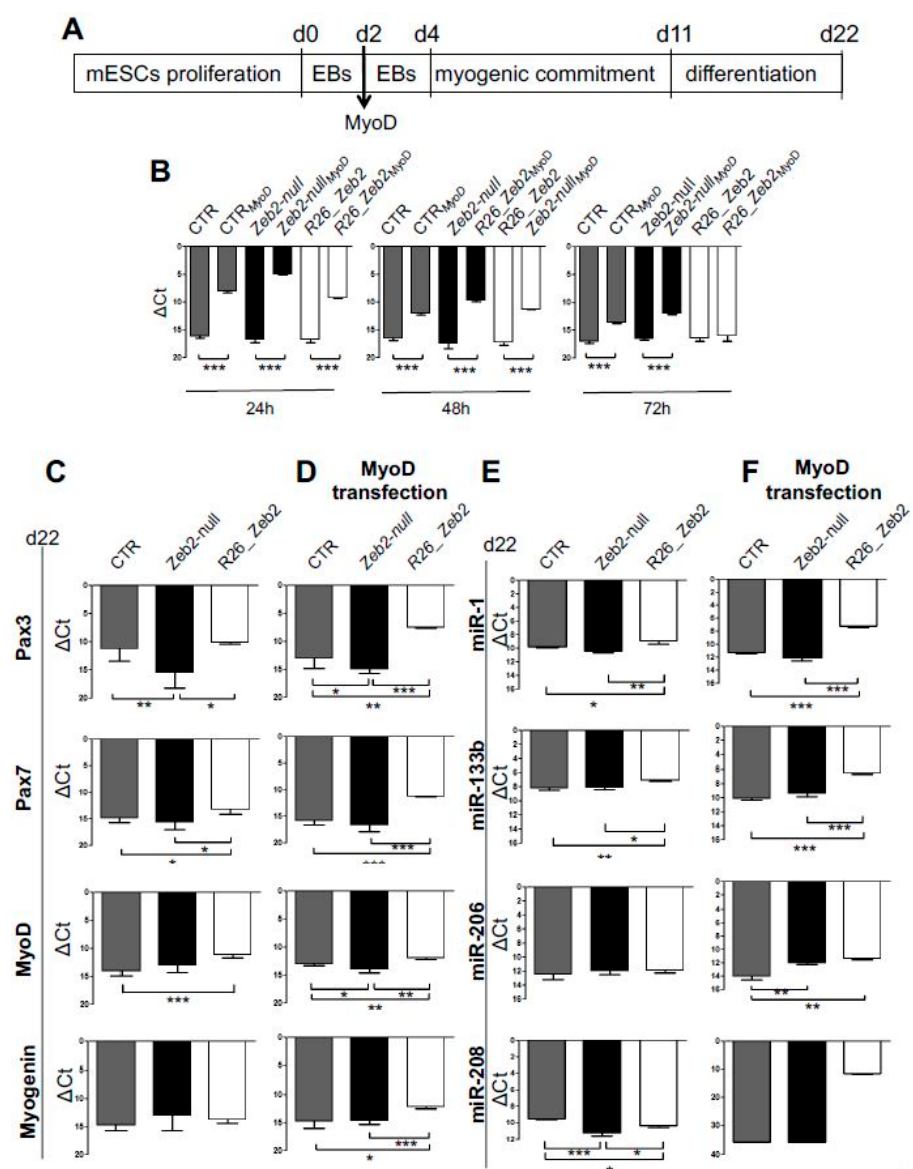
Figure 1. Muscle gene expression and MyomiR profile in Zeb2-null and R26_Zeb2 mESCs subjected to myogenic differentiation. ( A ) Schematic representation of myogenic induction for mESCs. ( B ) The qRT-PCR analysis confirms the successful MyoD transient transfection in CTR, Zeb2-null and R26_Zeb2 mESCs. At 24, 48, and 72 h from transfection, data are represented as ∆ C t , normalized for the housekeeping Gapdh . Values are shown as mean ± s.d.; n = 3, *** p < 0.0001. ( C , D ) qRT-PCR analysis for skeletal muscle genes ( Pax3 , Pax7 , MyoD , Myogenin ) in CTR, Zeb2-null and R26_Zeb2 mESCs, on day 22 from myogenic induction ( C ) or upon MyoD transfection ( D ). Each data point is represented as Δ C t , normalized for the housekeeping Gapdh . ( E , F ) qRT-PCR analysis for MyomiRs (miR-1, miR-133b, miR-208 and miR-206) in CTR, Zeb2-null and R26_Zeb2 mESCs, on day 22 from myogenic induction ( E ) or upon MyoD transfection ( D ). Each data point is represented as ∆ C t , normalized for the housekeeping miR-16. Values are shown as mean ± SD; n = 3, * p < 0.05, ** p < 0.005, *** p <